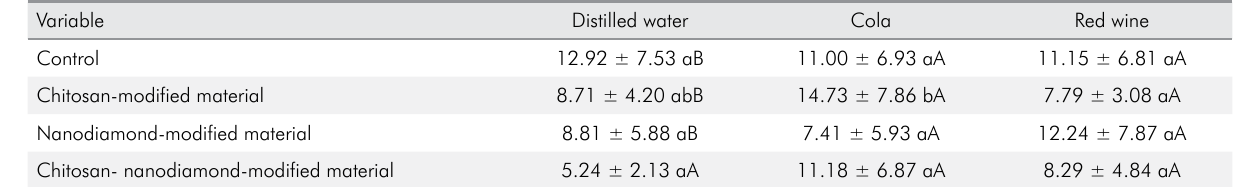
Table 4. Results of color stability ( Δ E ) of the materials after aging in different solutions.